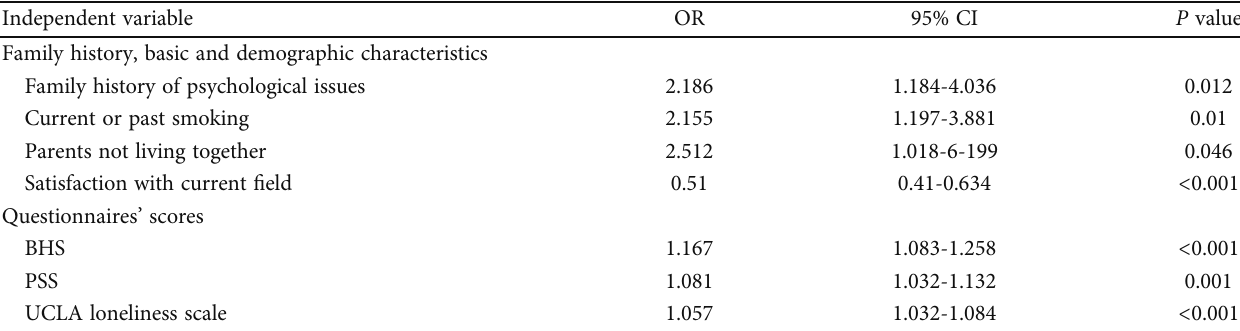
Table 3: Results of the multiple binary logistic regressions determining the factors associated with suicidal ideation among healthcare- profession